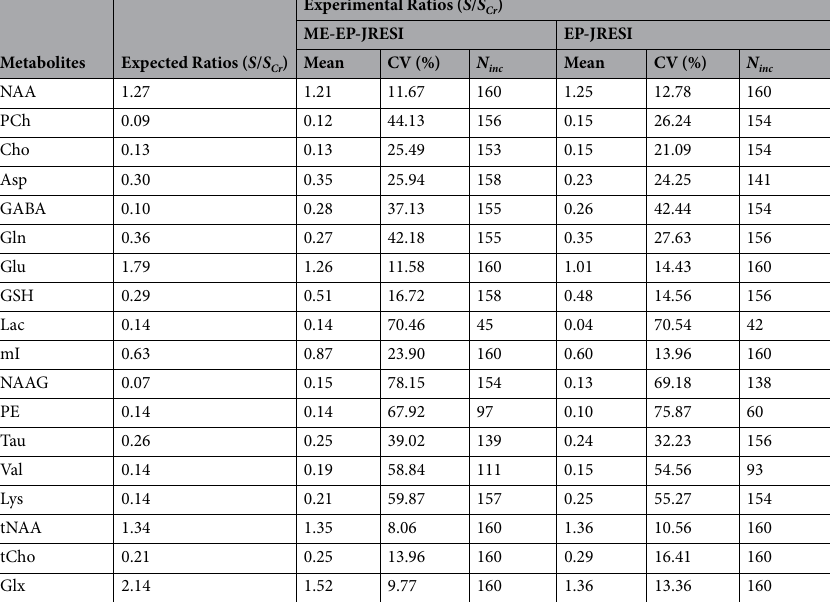
Table 1. Summary of the ProFit quantified results for selected metabolites for the two sequences. The central 4 × 4 voxels of the excited volume, as shown in Fig. 3 with the orange box, were processed. Ratios are shown with respect to Cr. N inc is the number of voxels in which ProFit reported CRLBs < 20%. Only those voxels were included for the mean ratios and CVs. ** tCho = Cho + GPC + PCh , tNAA = NAA + NAAG , Glx = Glu + Gln